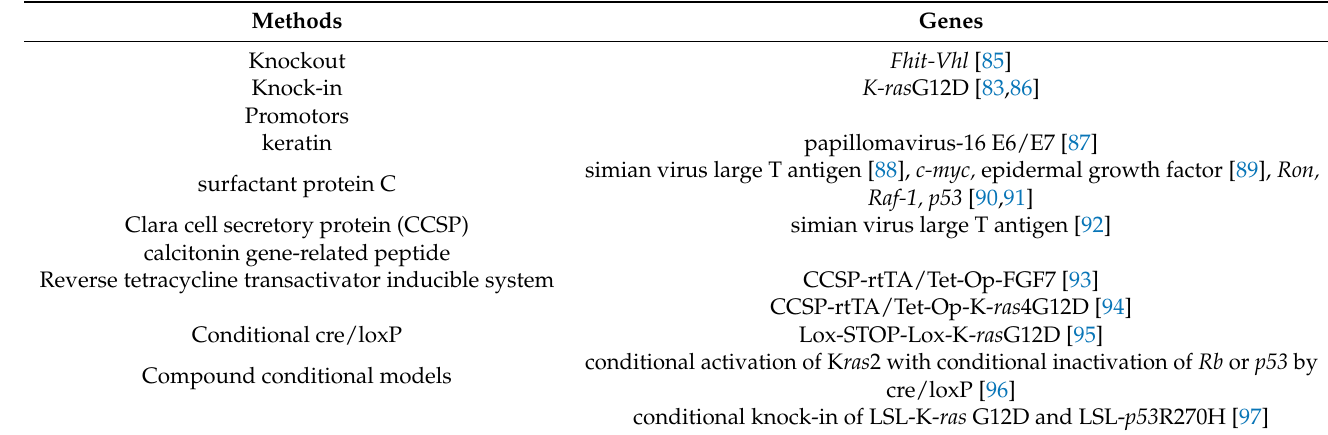
Table 2. Gene Mutation and Transgenic Animal Models